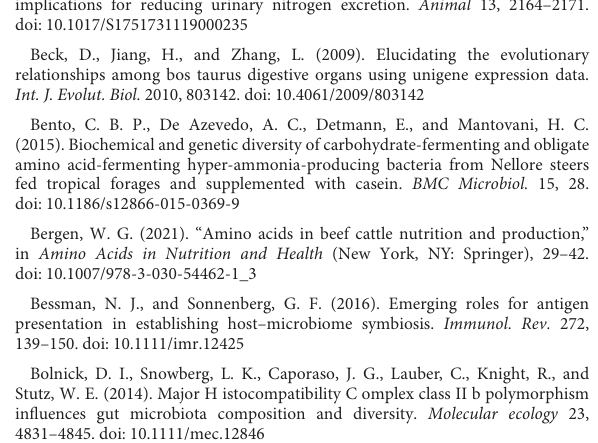
(Figure 3). p. 2: Correlation coefficients ( r -values) of the correlation analysis between microbial genera abundances and gene transcripts separating HMUg and LMUg cows (Figure